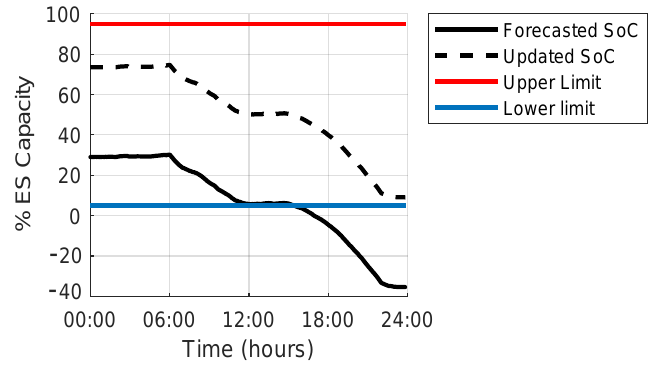
Figure 8. Day 2 initial SoC